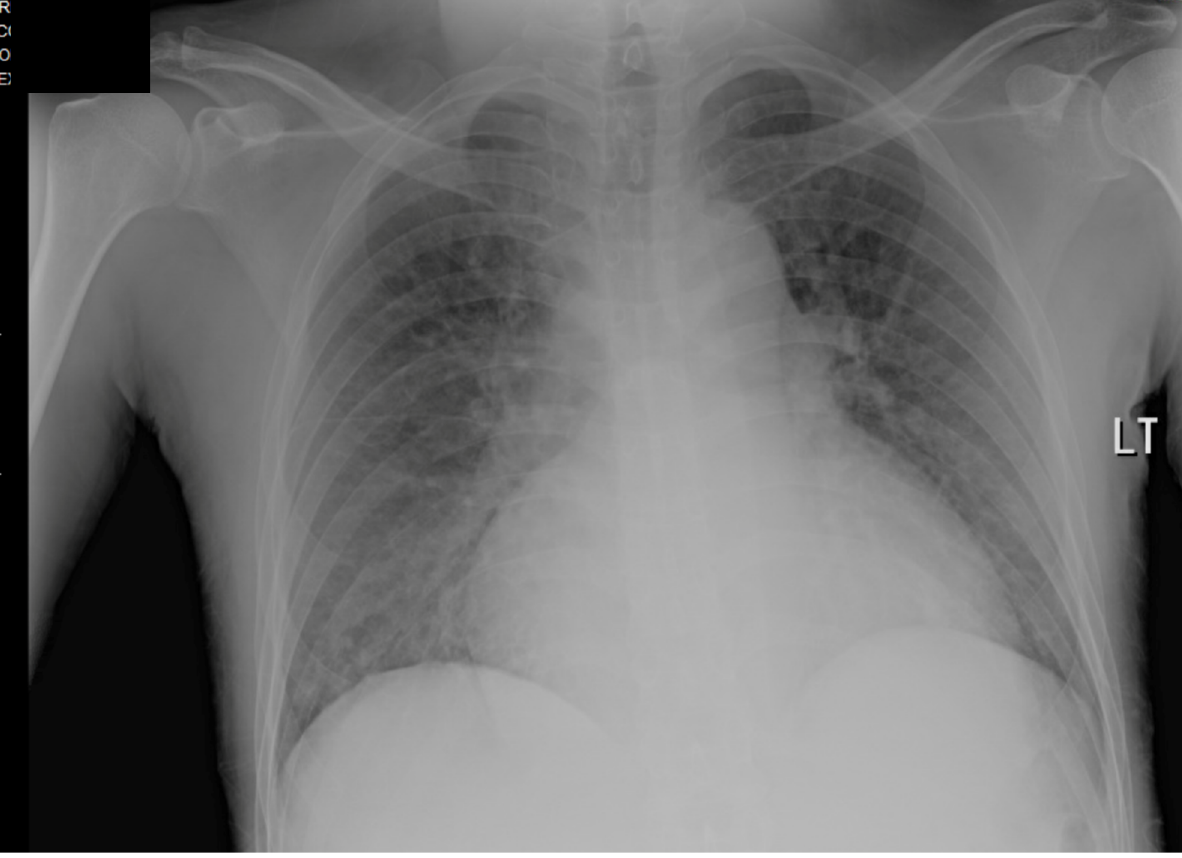
Figure 2. Chest radiograph on admission, demonstrating cardiomegaly.